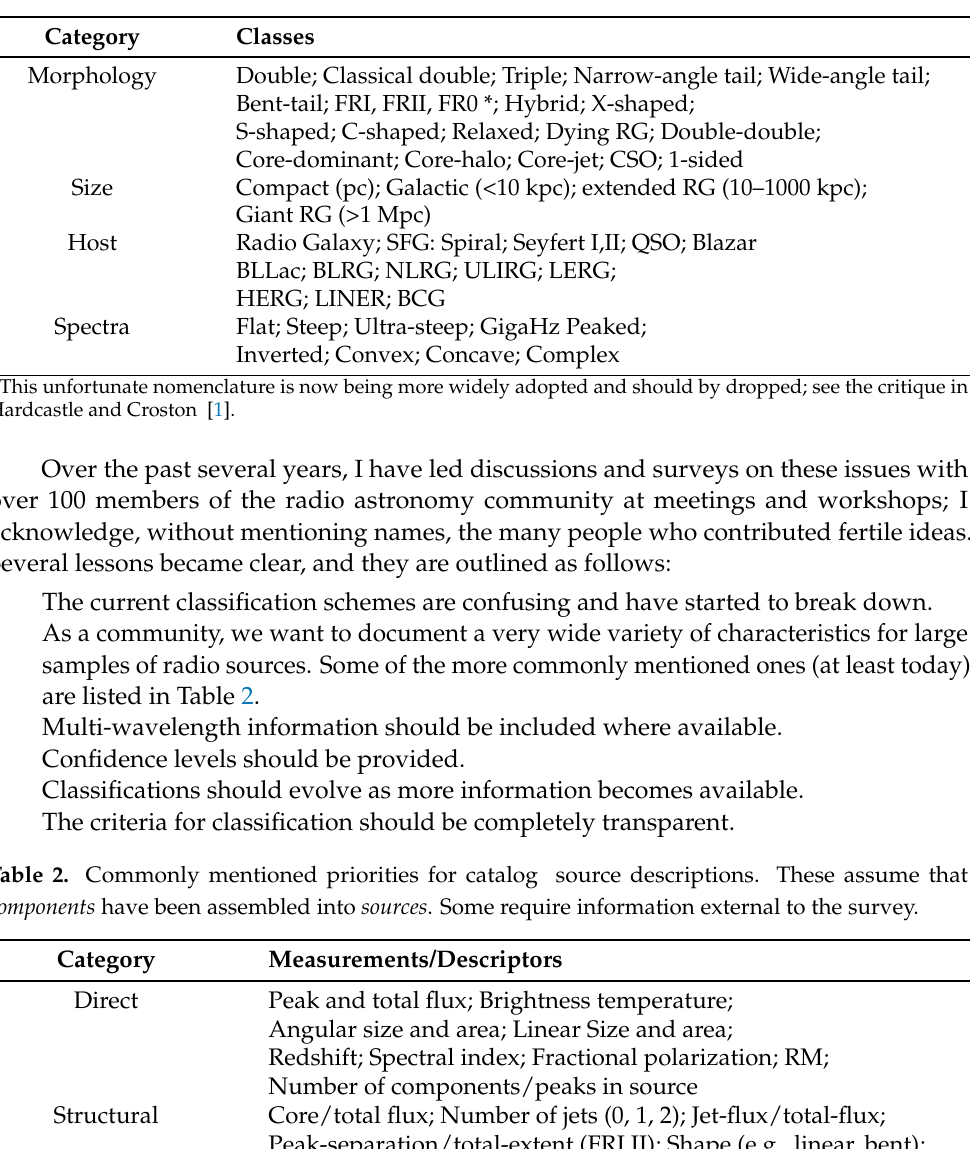
Table 1. Examples of radio galaxy classifications in current use.